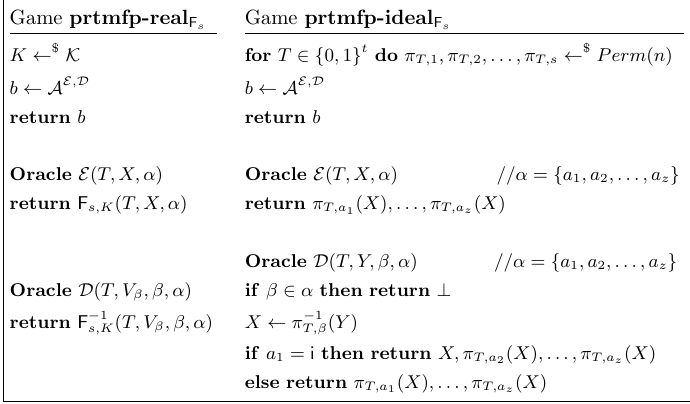
and prtmfp-ideal F s